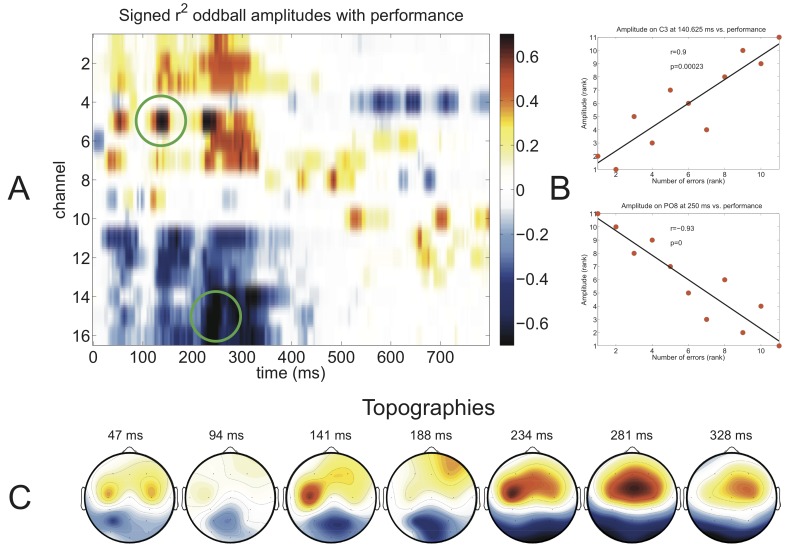
Signed r
2 values between auditory oddball amplitudes at all time points and channels with visual P300 BCI performance (defined as the number errors during the web browsing task) in red for positive correlations and in blue for negative correlations (A).Two elements were selected from the matrix (marked by green circles in A) for visualization using scatter plots (B) showing a correlation of r  =  0.9 (p < 0.01) on electrode C3 and a correlation of r  =  −0.9 (p < 0.01) on electrode Oz. Finally, topographic distributions of the signed r
2 values are shown at the bottom (C). Note that due to the use of “number of errors” as performance measure positive correlations indicate a decrease in performance with increasing amplitude, whereas negative correlations indicate an increase of performance with decreasing amplitude.